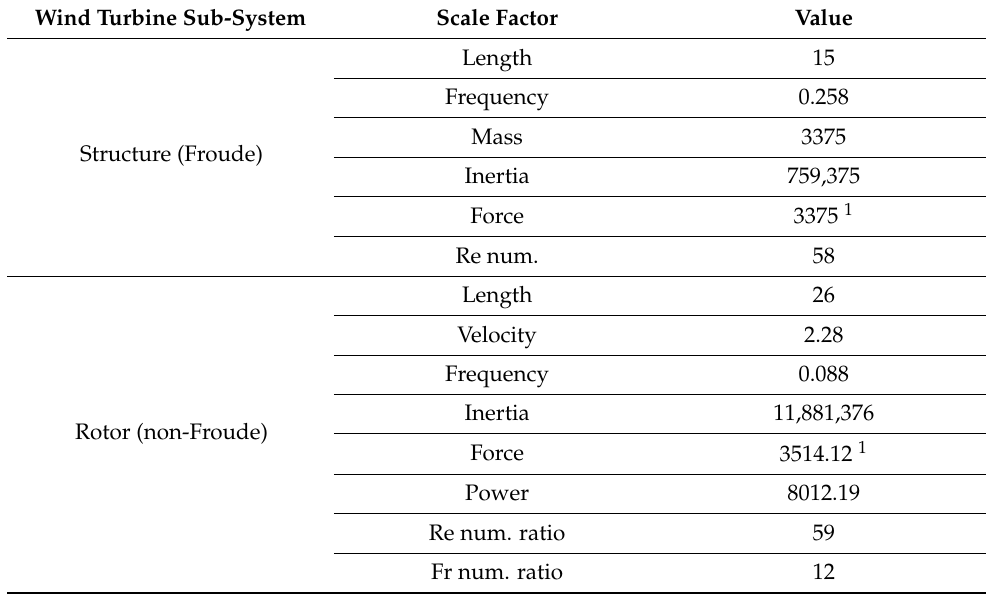
Table 3. Scale factors of the hybrid scaling of The Blue Growth Farm outdoor prototype turbine.